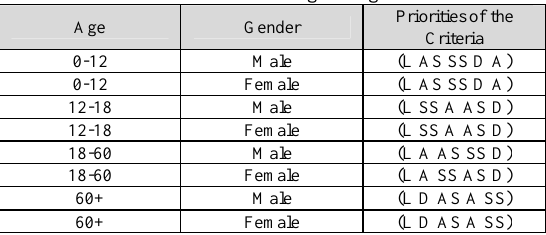
Table 3. Classification of the age and gender of users Age Gender